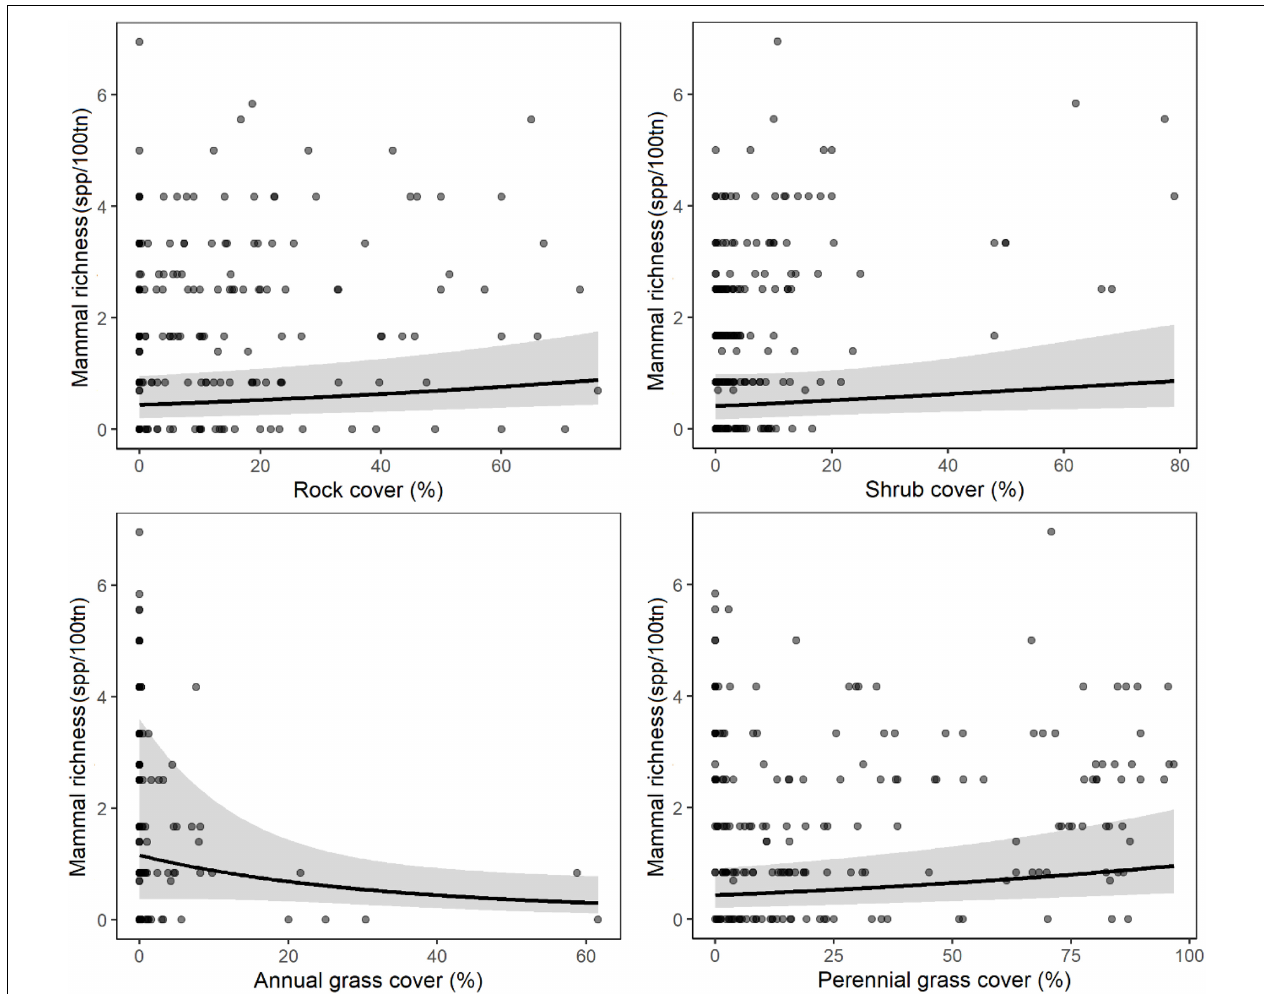
FIGURE 6 | Mammal richness [species per 100 trap nights (tn)] in volcanic habitat shown only for highly influential predictor variables sampled at all scales around each site (see Table 2 ). Relationships for each variable were derived from GLMM predictions while holding other explanatory variables constant at their median level. Model fit is shown by a black line and the gray band represents the 95% confidence interval. Gray circles indicate observed data values and are darker when repeated observations occur at the same